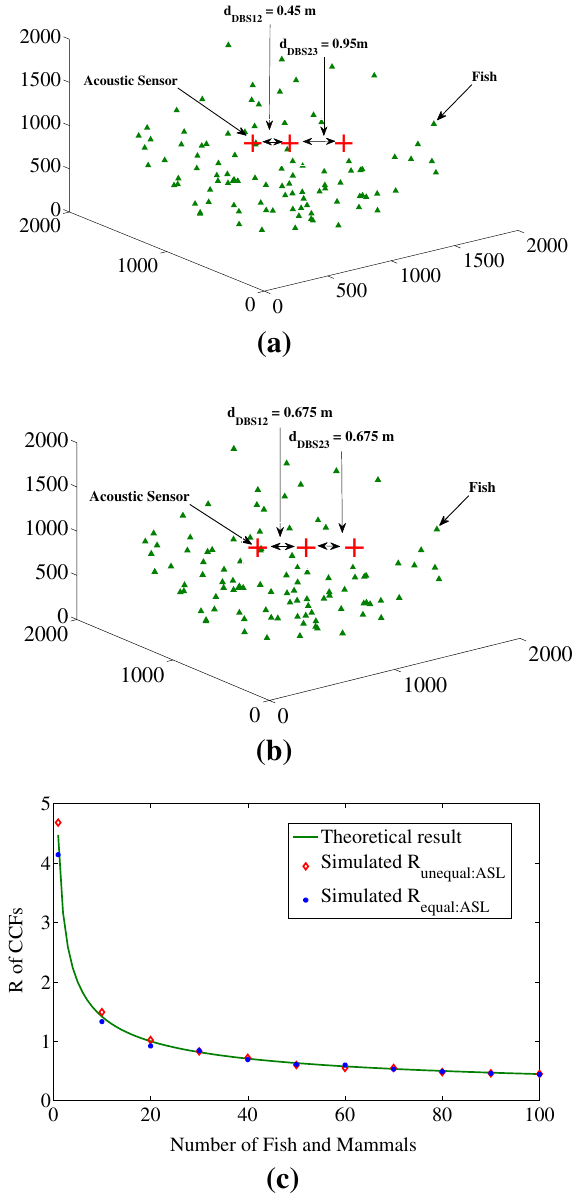
Figure 6. Scenario of unequal sensor separations and its corresponding results from simulations for three acoustic sensors ASL scheme ( a ) unequal sensor distances among acoustic sensors where d DBS12 = 0.45 m and d DBS23 = 0.95 m, ( b ) corresponding equal distances among acoustic sensors, i.e., d DBS = 0.675 m, derived from condition at Eqs. (15) and (20) and ( c ) Number of fish and mammals vs. R of CCFs for theoretical, and simulated with unequally and corresponding equally spaced acoustic sensors where the sensor distances are similar as in ( a ) and ( b ). Here, the axes units are in meter for ( a ) and ( b ). We used MATLAB R2010a to achieve this